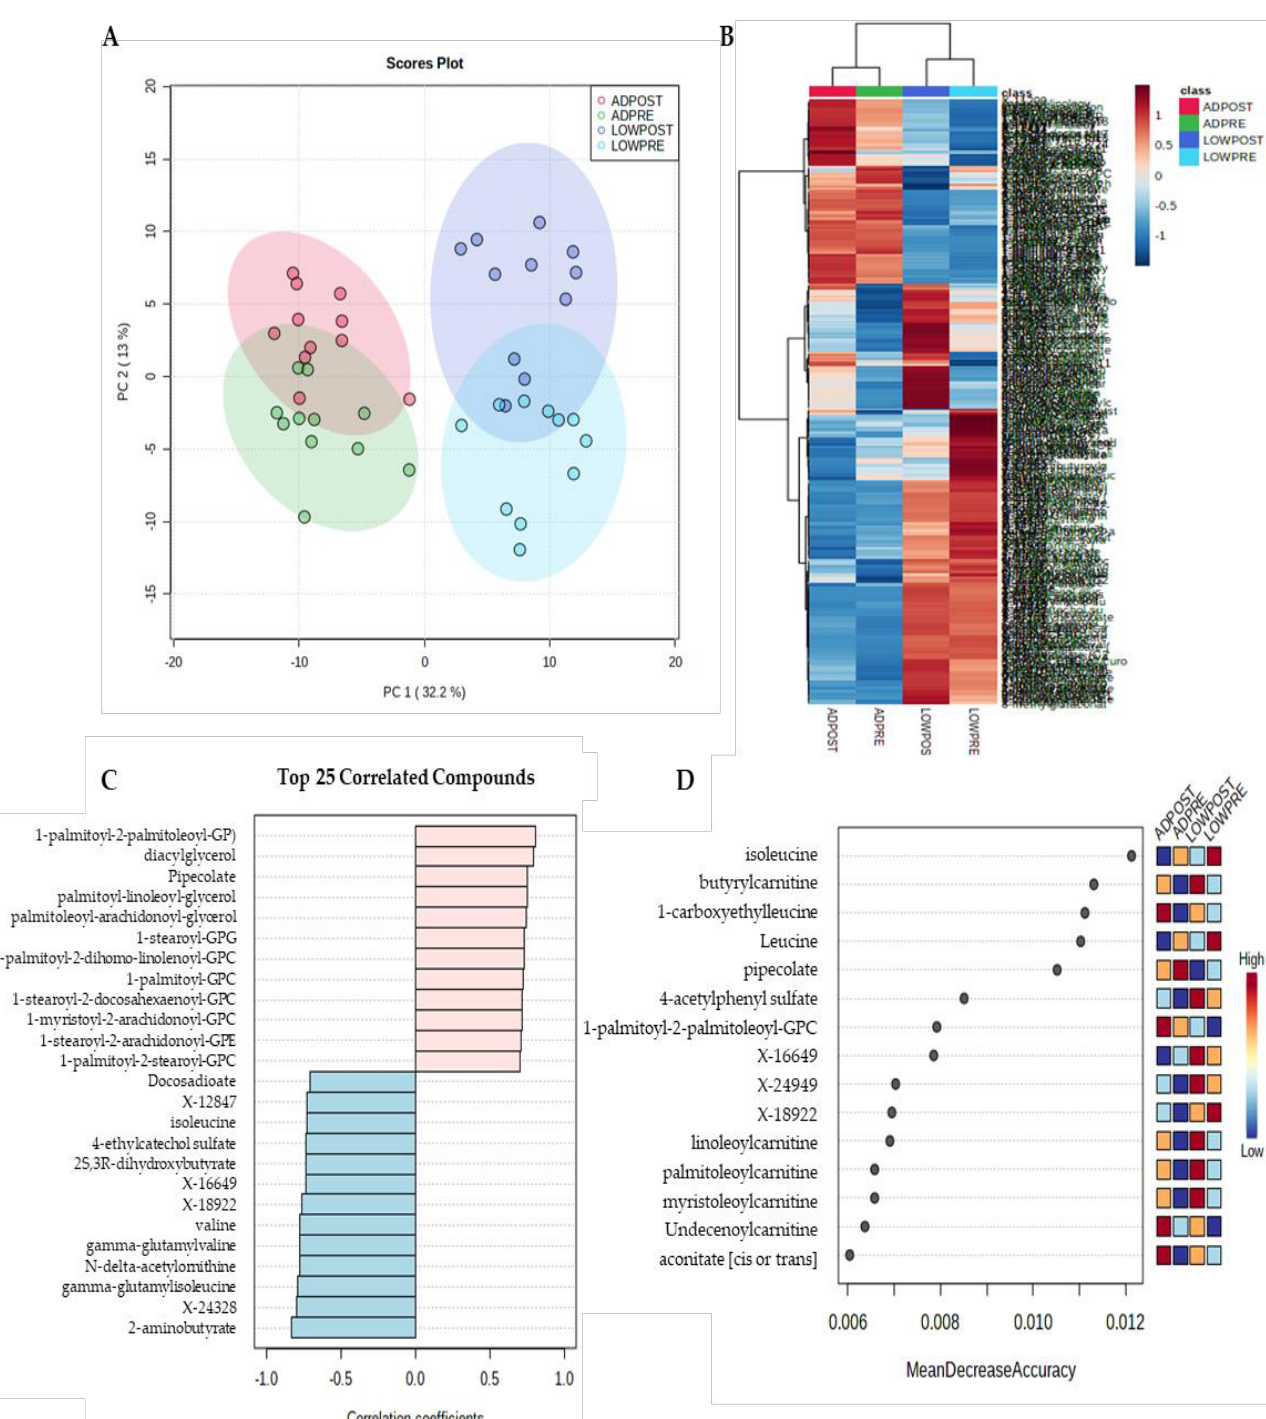
Figure 1. Principal component ( A ), hierarchical clustering ( B ), pattern hunter ( C ) and random forest plot ( D ) analysis; n = 11.